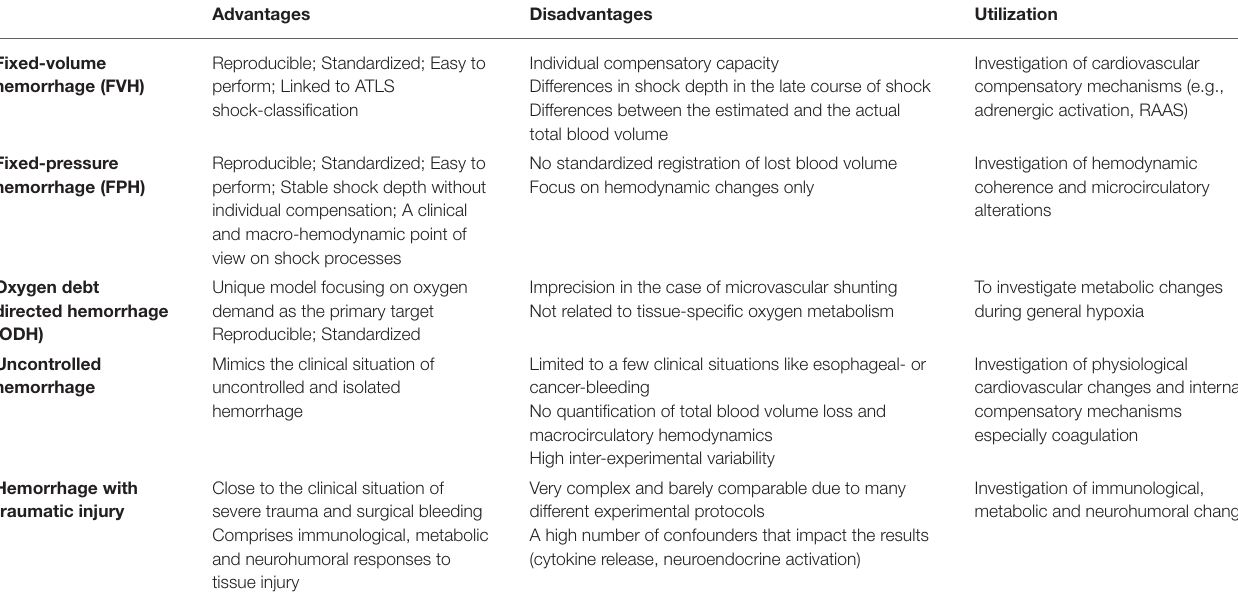
TABLE 1 | Experimental models of hemorrhage and their advantages / disadvantages and the specific areas which they are used